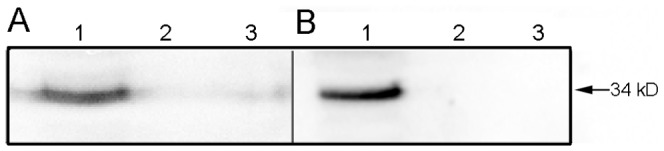
Western blot analysis of hITF.After infection of HT-29 cells by the adenovirus, western blot analysis of hITF in the cells (A) or culture supernatant (B) was performed. Lane 1, infection with Ad-hITF; Lane 2, infection with Ad-EGFP; Lane 3, HT-29 cells.